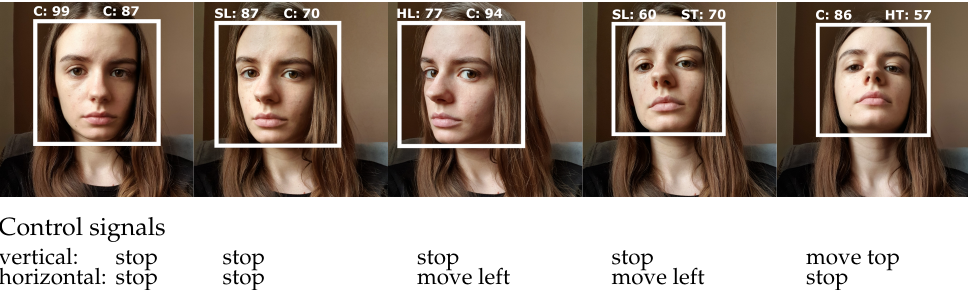
Figure 8. Video frames from the camera pointed at the operator’s face. The white rectangle represents the head bounding box, whereas the values above describe the head estimation output class, together with